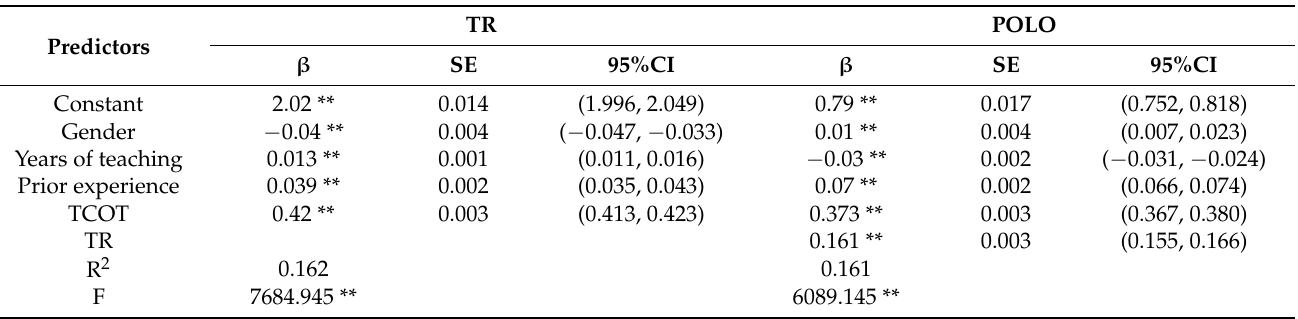
Table 2. The mediation model of teacher resilience between teacher competence in online teaching and perceived online learning outcomes.